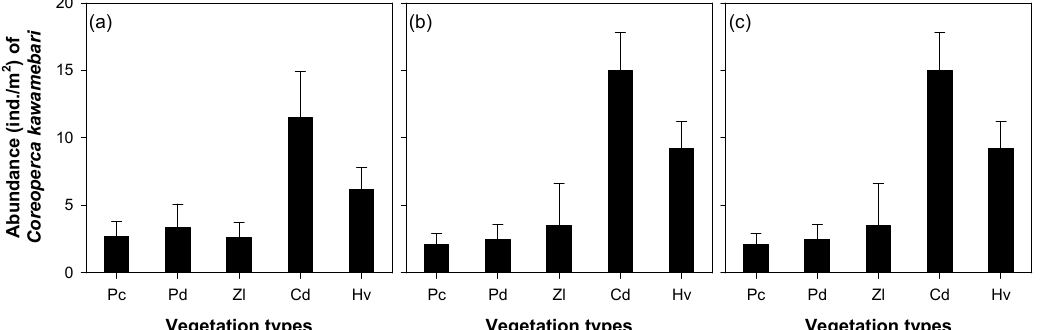
Figure 4. Abundance of Coreoperca kawamebari according to five vegetation types in three study sites (from the left, sites 2, 4, and 8) located in the upper parts of the Geum River. Means labeled with a different letter indicate statistical subgroups defined by the post hoc test (Tukey honest significant difference (HSD), P = 0.05). Pc, Phragmites communis ; Pd, Paspalum distichum ; Zl, Zizania latifolia ; Cd, Ceratophyllum demersum ; Hv, Hydrilla verticillata . ( a ) site 2, ( b ) site 4, and ( c ) site 8.